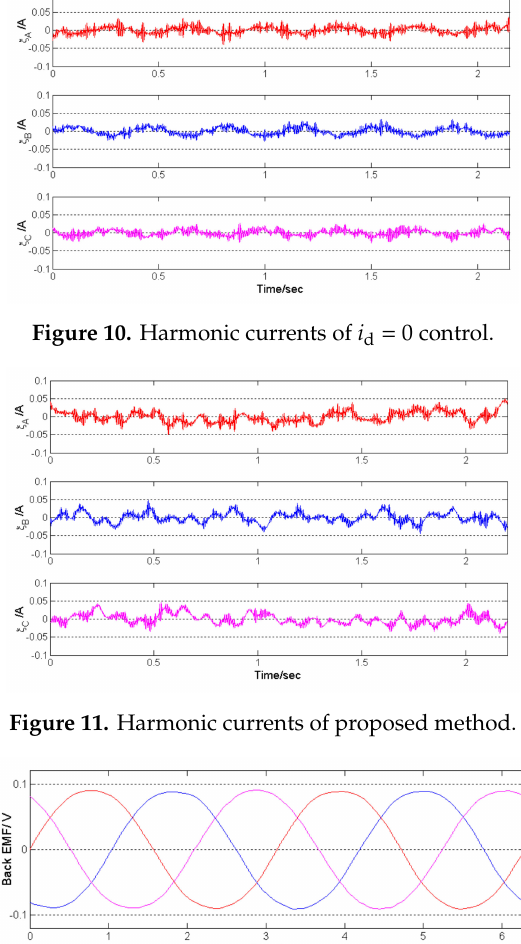
Figure 12. Back electromotive force (EMF) waveforms of test PMSM with unit speed.